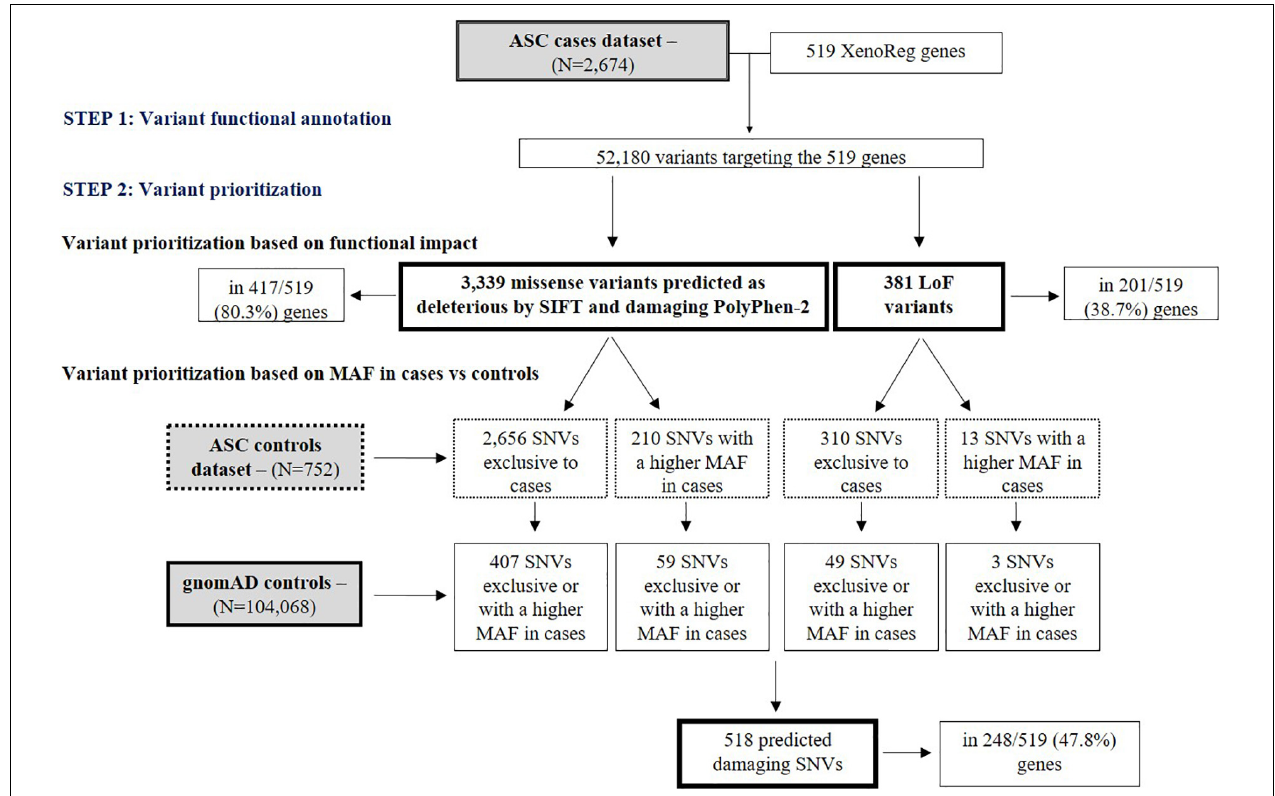
FIGURE 2 | Flowchart of main results regarding SNV analyses. Shown are the numbers of LoF and missense (predicted as deleterious by SIFT and damaging by PolyPhen-2) SNVs in XenoReg genes, in ASD cases from ASC when compared to controls from ASC and gnomAD. The functional impact of variants present in ASD cases was predicted by VEP and only LoF and missense SNVs predicted to be deleterious by SIFT and damaging PolyPhen-2 were considered. The MAF of these variants was then compared with that from ASC controls and gnomAD subjects not ascertained for having a neurological disorder. ASC, Autism Sequencing Consortium; ASD, Autism Spectrum Disorder; gnomAD, Genome Aggregation Database; MAF, Minor Allele